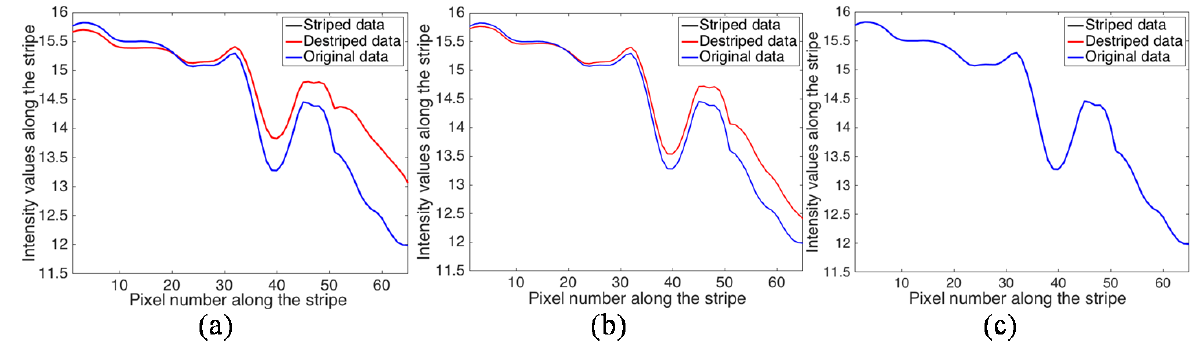
Figure 4. This figure shows the effects of destriping on the places where there are “no stripes”. We randomly picked the 67th row for this comparison. When α = 1 in the unweighted regularization functional, the image is more smoothed and affects destriping to the whole image. Much better results can be obtained from the unweighted regularization functional with α = 3 × 10 − 1 , which is the U -curve solution and is shown in graph (b) . A spatially weighted regularization term with α = 7 × 10 − 1 has less of an effect on the other features of the image and we can observe that from the graph (c) .